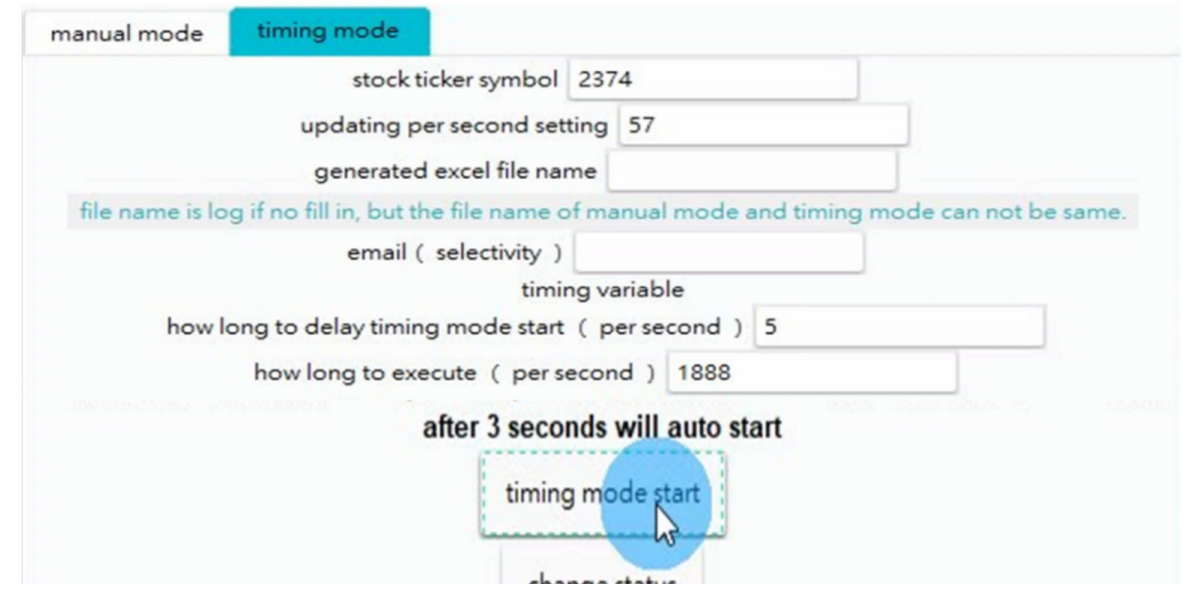
Figure 11. Timing mode after 3 s will auto start.